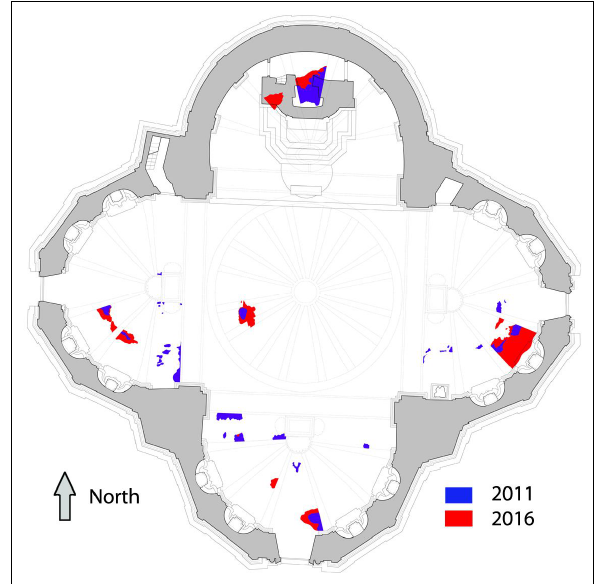
Figure 11. Moisture patches on the dome intrados